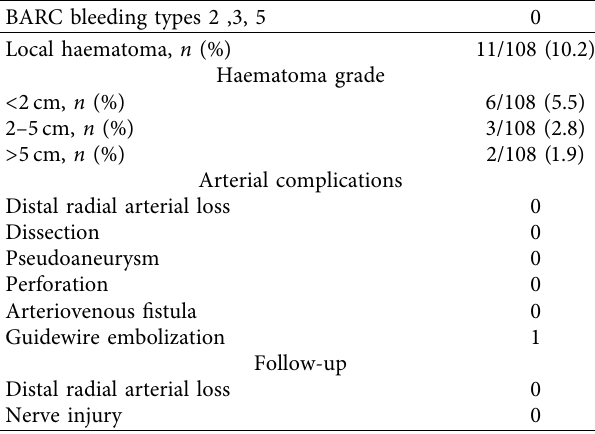
Figure 6: (a) Comparison of left distal radial and right radial mean procedure duration, (b) median fluoroscopic time during left distal radial and right radial procedures, and (c) median radiation dose (DAP) during left distal and right radial procedures. Table 5: Puncture site complications.